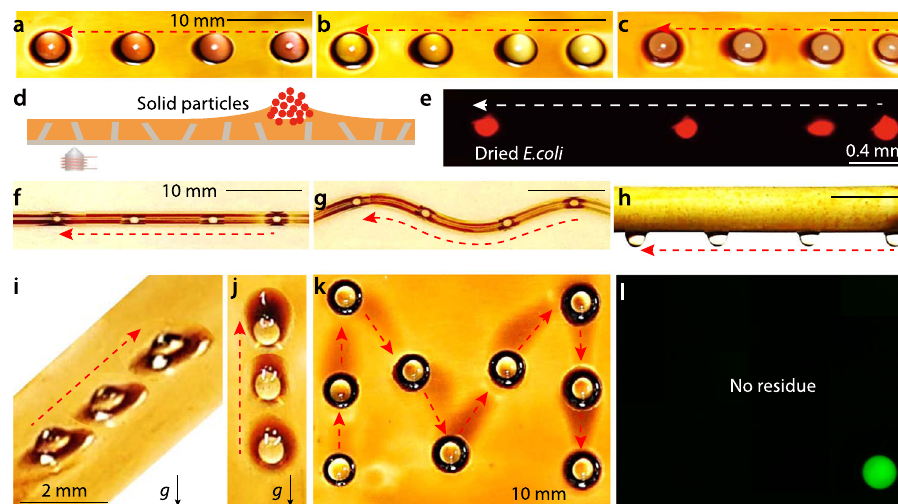
Fig. 2 Versatility of the actuation. a – c Actuation of biological droplets of Dulbecco ’ s modi fi ed Eagle medium (DMEM, a ), fetal bovine serum (FBS, b ), and buffy coat ( c ). d , e Schematic illustration and fl uorescence image showing the actuation of solid samples (dried E.coli cells). E.coli was dyed with propidium iodide (a dye that visualizes dead cells). f , g Actuation of a droplet inside a straight ( f ) or curved ( g ) tube with the inner surface infused with ferro fl uid, which is useful in closed micro fl uidics. h Actuation of a droplet hanging upside down on the rod with the outer surface infused with ferro fl uid. i , j On an open surface, the droplet could be transported against gravity, either when the surface was tilted by 45° ( i ) or 90° ( j ). The black arrows and the symbol g indicate the direction of the gravitational force. k By programmed sequential actuation of neibhourghing electromagnets, the droplet was guided to walk along a M-shape path. Electromagnets were beneath the droplets ’ snapshots. The droplet was dyed with fl uorescent molecules. l The fl uorescence image of the fi nal state in k did not show any residue fl uorescence on the walked path, suggesting the anti-fouling property. Dotted arrows indicate the moving direction of the actuated